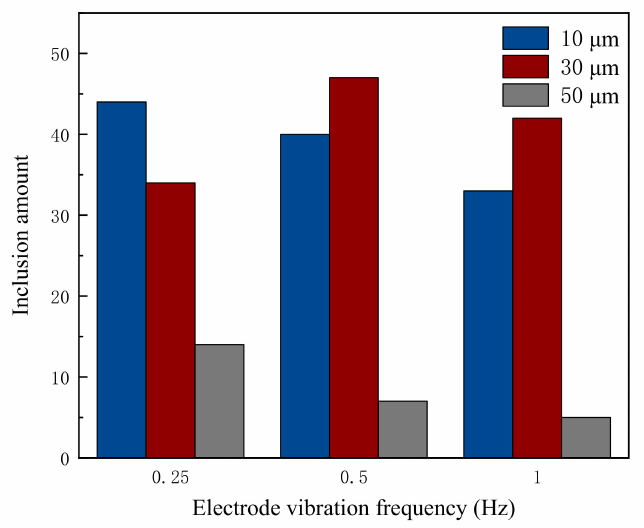
Figure 8. Effect of electrode vibration frequency on inclusion removal ratio with different diameter.